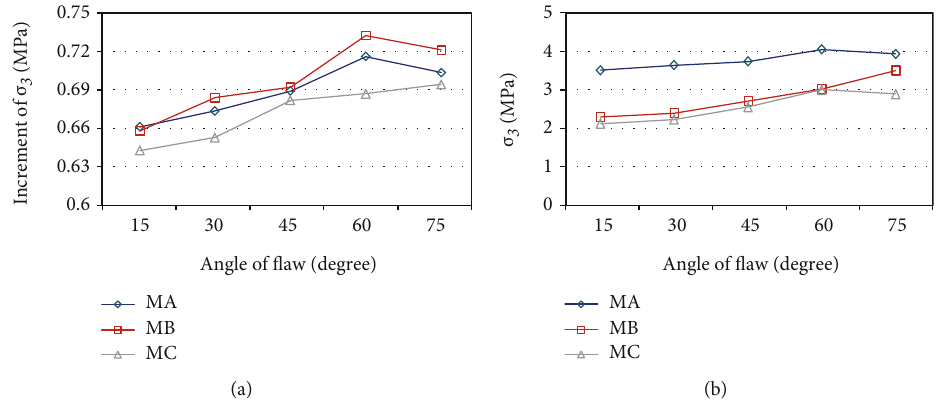
σ 3 and 3 by monitoring points: (a) incremental tensile stress; (b) total tensile